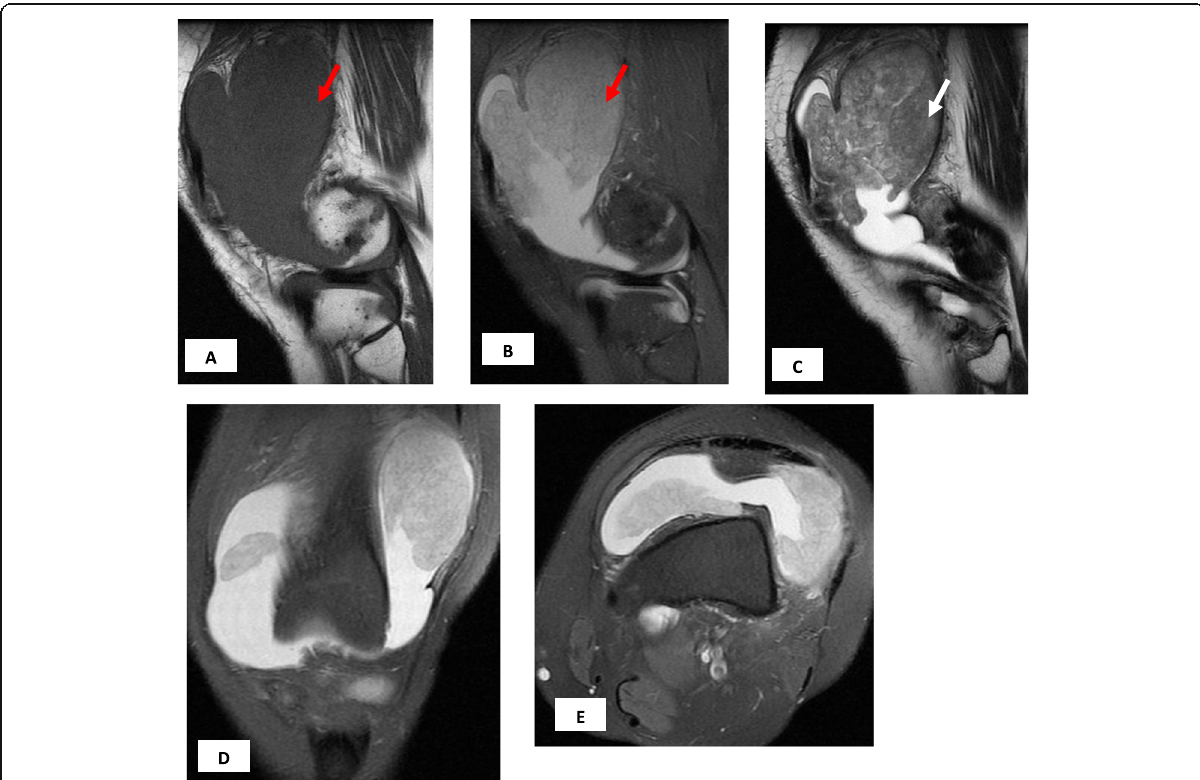
Fig. 6 Right knee diffuse PVNS in 40-year-old male. Sagittal T1 ( a ), sagittal STIR ( b ), sagittal T2 ( c ), coronal STIR ( d ), and axial STIR ( e ) show large lobulated, mass-like synovial proliferation with low signal intensity (red arrow), no articular erosions. Sagittal T2 demonstrate massive synovial proliferation with low signal foci of hemosiderin (white arrow) and associated joint